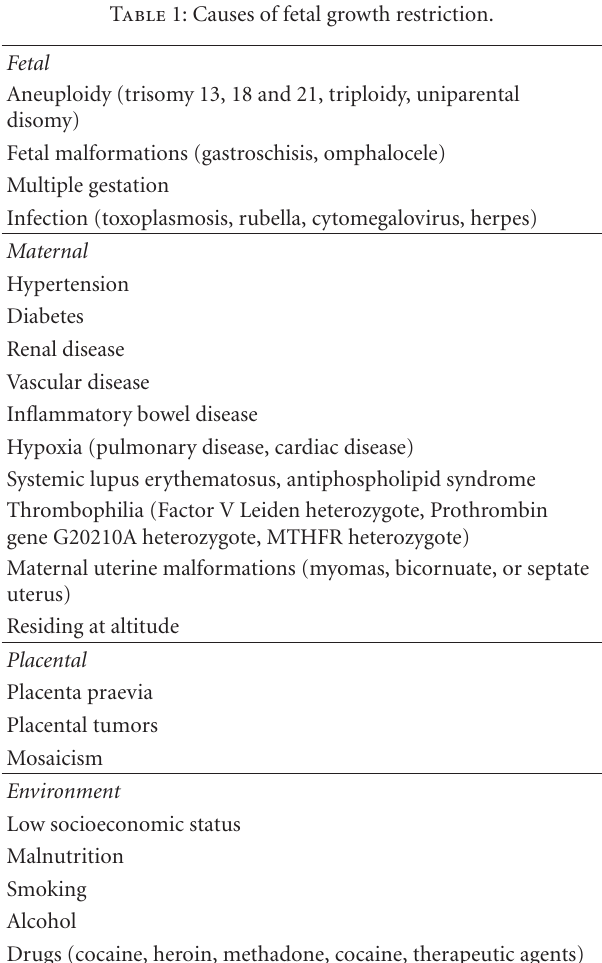
Table 1: Causes of fetal growth